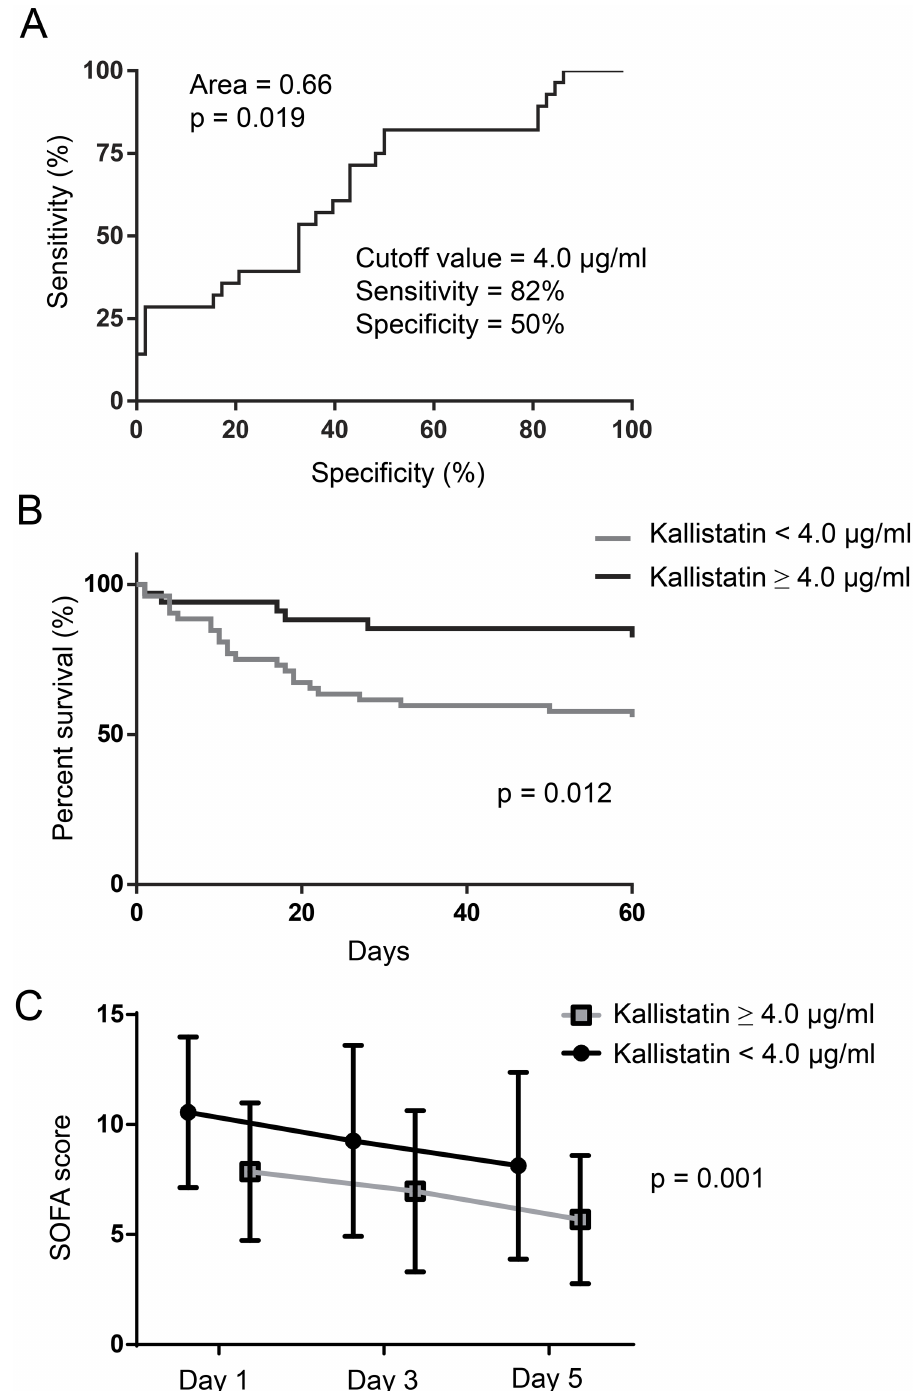
Fig 3. ROC curve and Kaplan-Meier curve analyses for 60-day mortality and stratified SOFA scores for days 1–5 days related to plasma kallistatin levels on day 1 of ICU admission in severesepsis and septic shock patients. (A) ROC curves determining the cutoff value of day 1 kallistatin(4.0 μ g/ml) to discriminate betweensurvivors and nonsurvivors. (B) Kaplan-Meier curves of 60-day survival with patients groupedaccordingto day 1 kallistatin levels (cid:21) 4.0 μ g/ml or < 4.0 μ g/ml. Log-ranktest for comparisons betweengroups. (C) SOFA scores on days 1, 3, and 5 in patients groupedaccordingto day 1 kallistatin levels (cid:21) 4.0 μ g/ml or < 4.0 μ g/ml. Mixed model comparisons